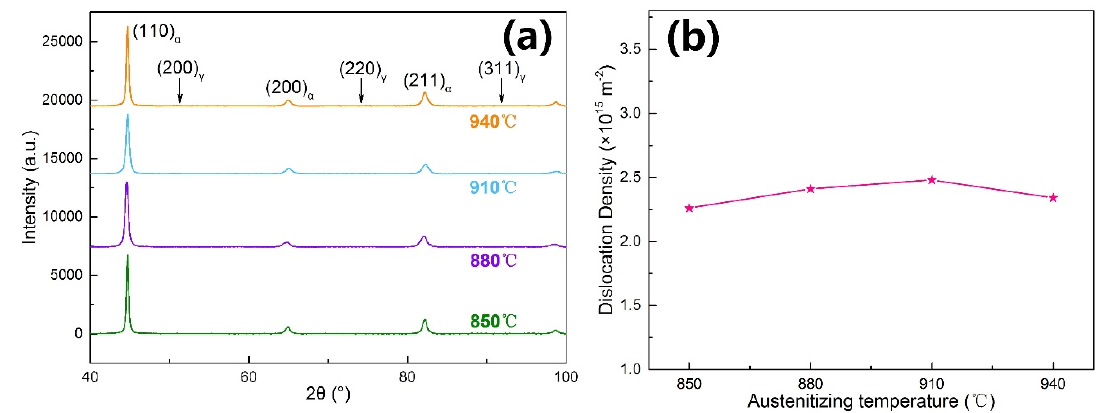
Figure 9. ( a ) X-ray diffraction (XRD) spectra and ( b ) dislocation density of MCLA martensitic steel austenitized at 850–940 °C.